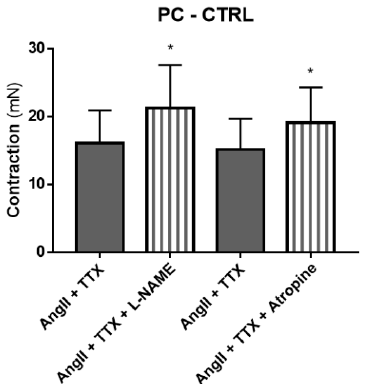
Figure 8. Contractile response to Ang II in the PC of control animals in the presence of TTX 1 µM (dark gray bars) compared to the presence of TTX and L-NAME 100 µM ( n = 6) or atropine 1 µM ( n = 5) (striped bars). * p < 0.05 vs. Ang II with TTX.